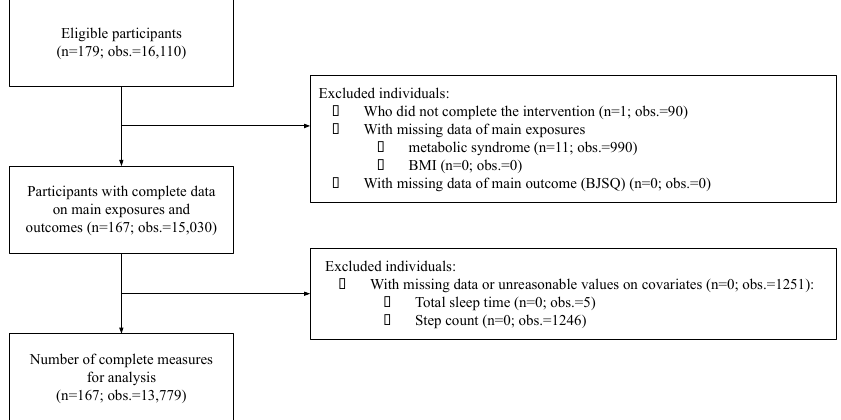
Figure 1. Flowchart illustrating the inclusion and exclusion of participants ( n ) and observations (obs.) in the present study.